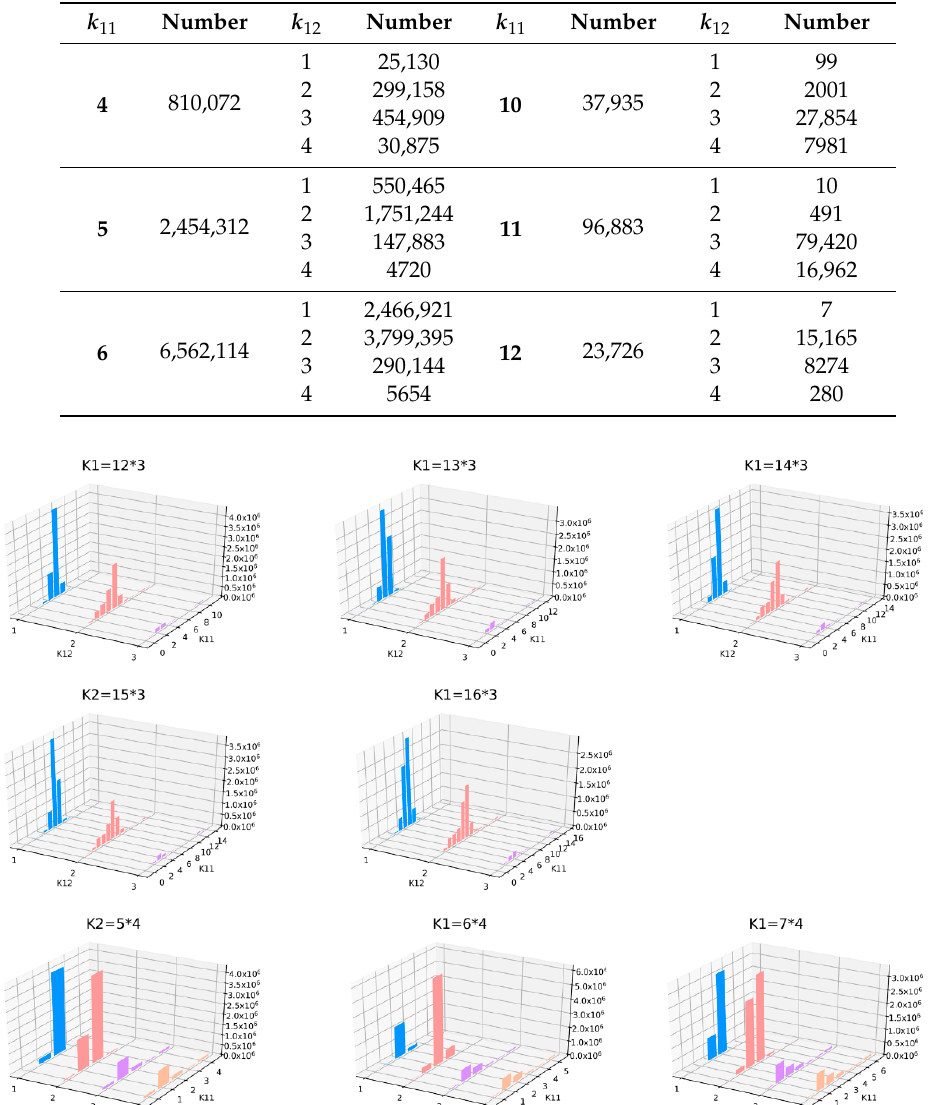
Figure 6. Frequency distribution histogram of k 1 ( k = 2).